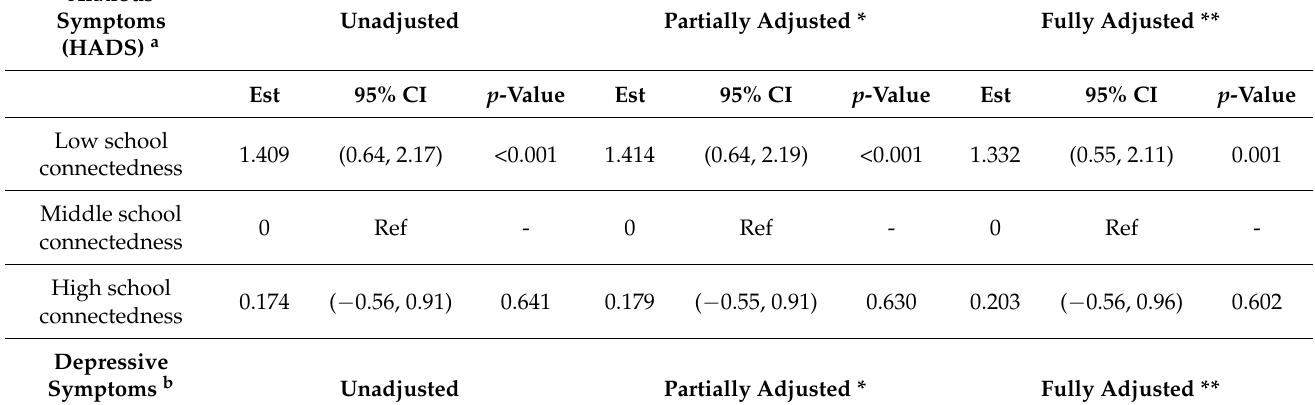
Table 3 reports the association between pre-pandemic levels of school connectedness and change in anxious and depressive symptoms and well-being scores between lockdown (May 2020) and the return to school (October 2020). In the fully adjusted models, low school connectedness at baseline was associated with a greater increase in anxious symptoms ( β = 1.332, p = 0.001, 95% CI [0.55, 2.11]) and depressive symptoms ( β = 0.869, p = 0.010, 95% CI [0.21, 1.53]) between lockdown and the return to school, when compared to stu- dents with medium levels of school connectedness. Although well-being scores decreased from lockdown to the return to school for students reporting low school connectedness as baseline, this was a smaller effect, with 95% confidence intervals just crossing 0 ( β = − 1.91, p = 0.056, 95% CI [ − 3.87, 0.05]). There was no evidence to suggest a difference in change scores for those with high compared to medium levels of connectedness for anxious symp-